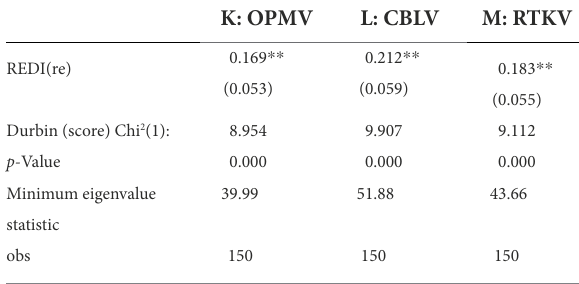
TABLE 7 Endogeneity test: Digital economy and product innovation.